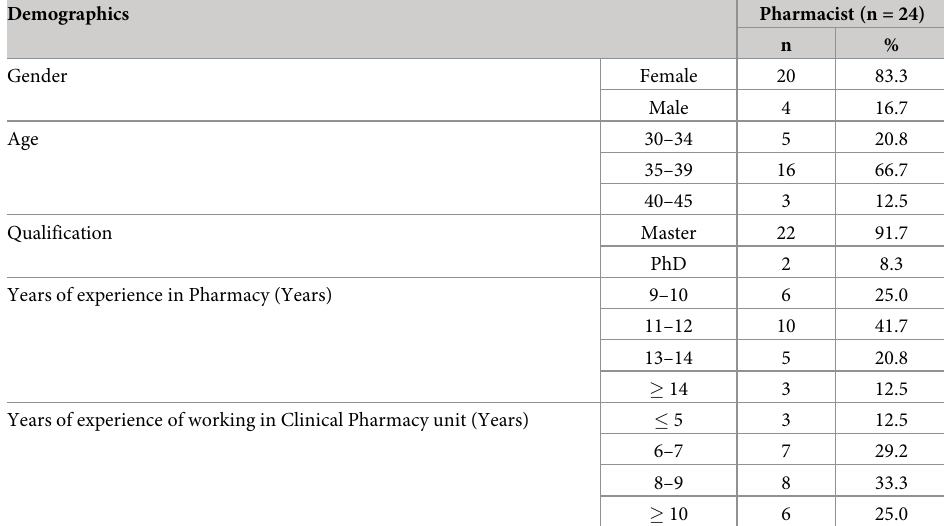
Table 1. Characteristics of expert panels.